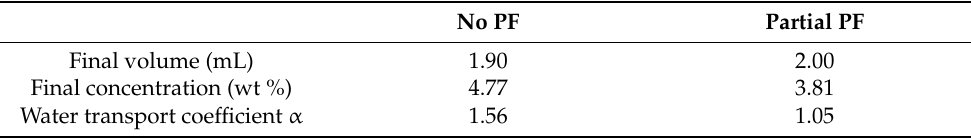
Table 1. Water transport coefficient of no PF cathode and partial PF Figure 8. The cathode potential of no PF cathode and partial PF cathode under 80 mA cm -2 with 2 M methanol solution.